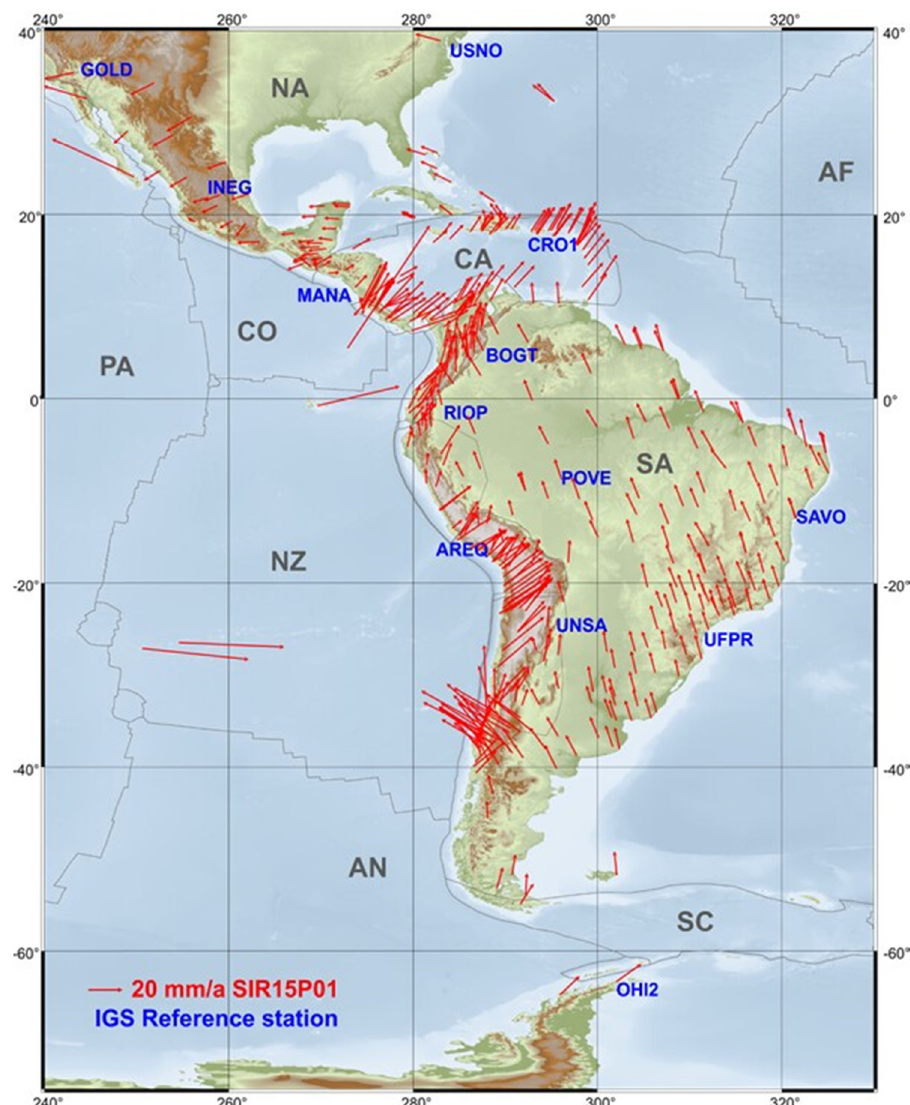
Figure 7: Station velocities from the SIRGAS multi - year solution SIR15P01 ( 2010 - 03 - 14 through 2015 - 04 - 11 )